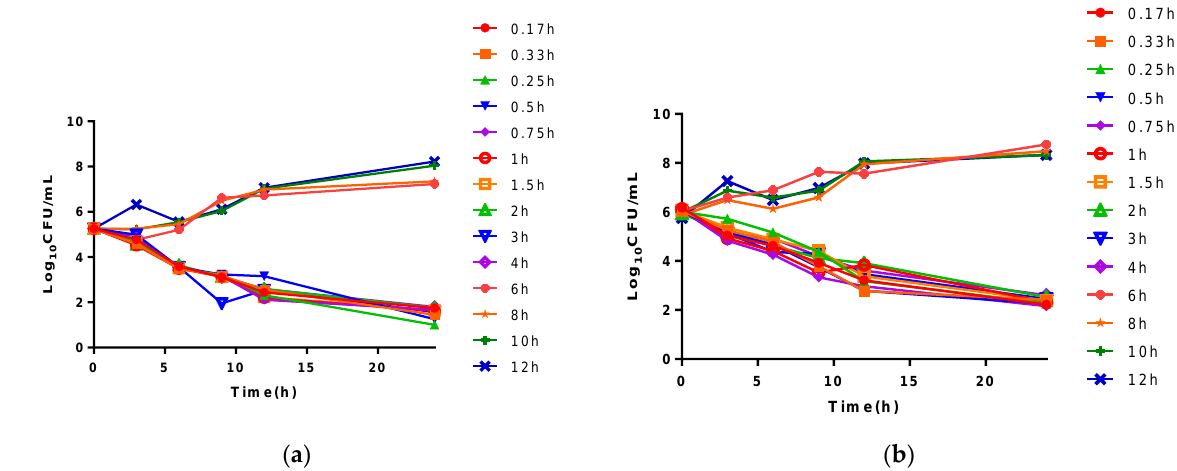
Figure 4. The ex vivo time-killing curves of cefquinome against S. suis. ( a ) represents in healthy group plasma; ( b )represents in infected group plasma. The legends mean different plasma samples after cefquinome administration.